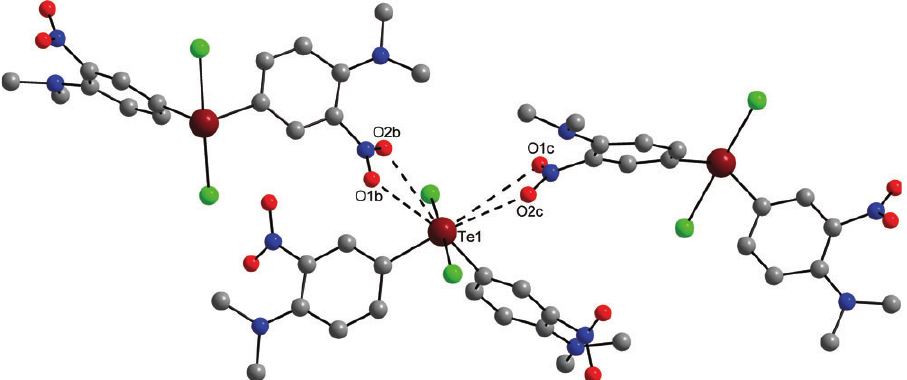
Figure 2 Crystal structure of [(4-Me Te ‧ ‧ ‧ O interactions (symmetry operation used to generate equivalent atoms: b = 1.5-x, -0.5 + y, 0.25 + z; c = -0.5 + x, 1.5-y, 1.25-z). Selected bond distances [ Å ]: Te1 ‧ ‧ ‧ O1b 3.660(3), Te1 ‧ ‧ ‧ O2b 3.162(3).